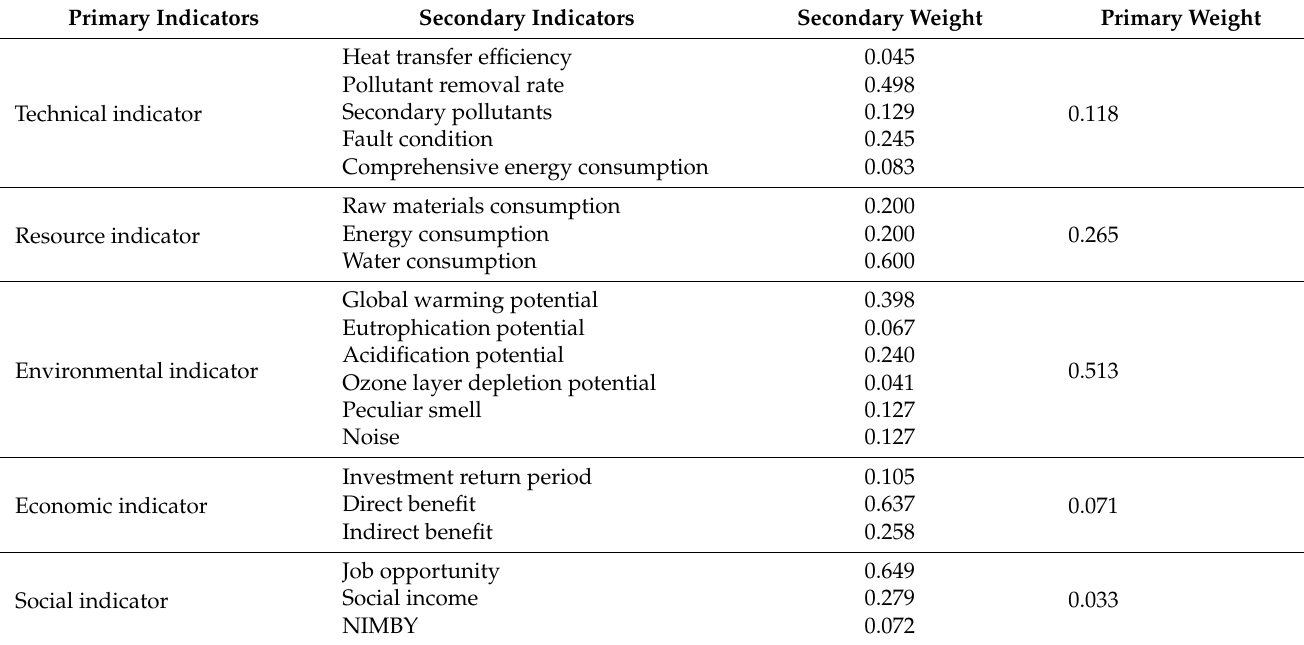
Table 9. Weight coefficient.